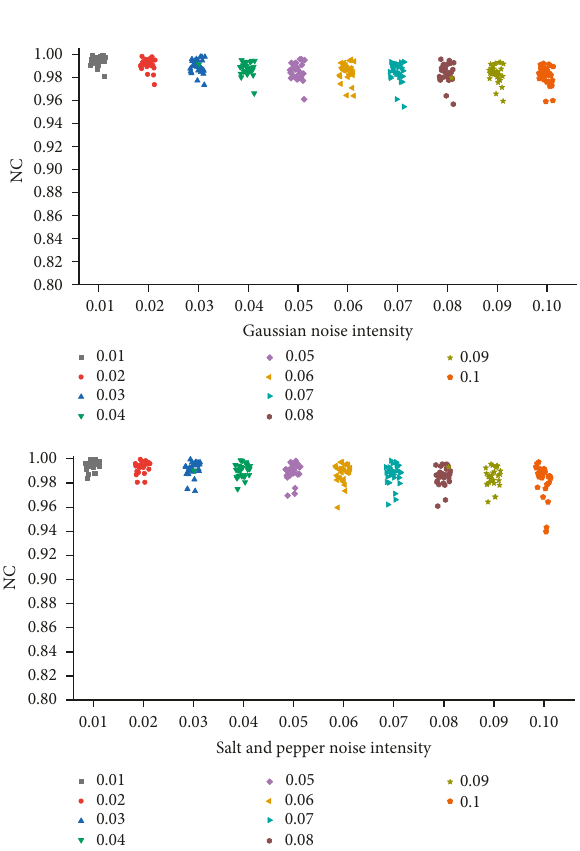
Figure 9: NC value under noise